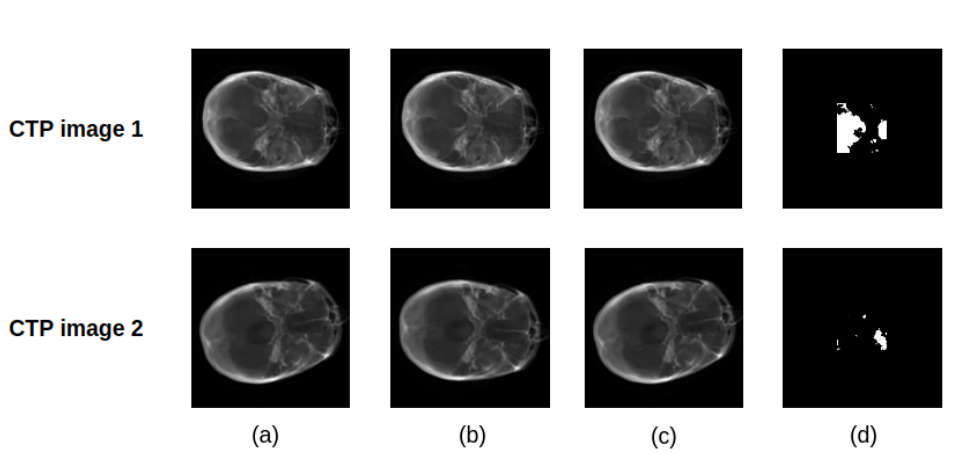
Figure 2. Example of each step output of the mutation model using CTP image. ( a ) Distance map, ( b ) rotation, ( c ) mutation, and ( d ) show the adjacent location where the white regions are mutated. Algorithm 2 demonstrates the method of the computing distance map. The Euclidean distance is used to create the horizontal and vertical distance maps. First, a 2-dimensional (2D) array locates the intensity value of the right neighbor pixel for each CTP image pixel. The second 2D array is used to modify the spatial dimension of the CTP image to the same dimension of the first 2D array while preserving the location of each pixel. Then, the Euclidean distance computes the distance between every two corresponding pixels in these two 2D arrays. Second, the same scenario is used to compute the vertical distance map, where the first 2D array is used to locate the intensity values of the bottom neighbor for each CTP image pixel. Finally, the distance map is the average of these two maps, where it is normalized to the